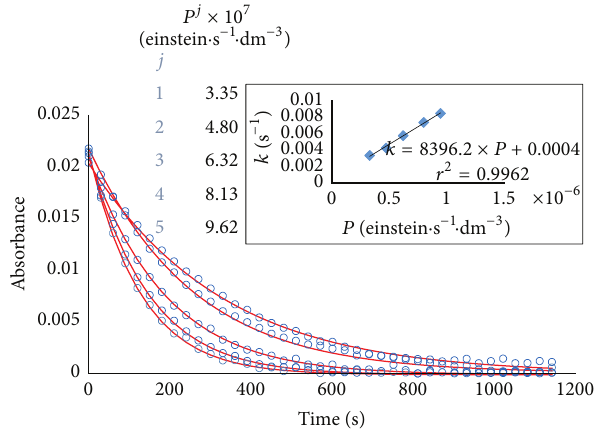
𝑗 370 , on NIS kinetic 𝑃 𝑗 370 .